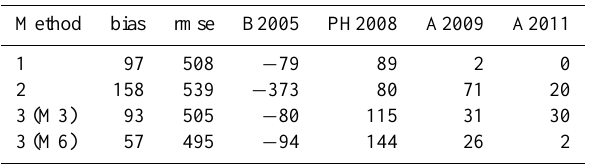
Table 1. Validation of annual mass balance extrapolated using (1) arithmetic averaging, (2) glacier hypsometry, and (3) multi- ple regression with three (M3) or six variables (M6) against in- dependent WGMS data and geodetic regional mass balances. The mean bias ( B ex − B obs ) and the rms error in mmw.e.a − 1